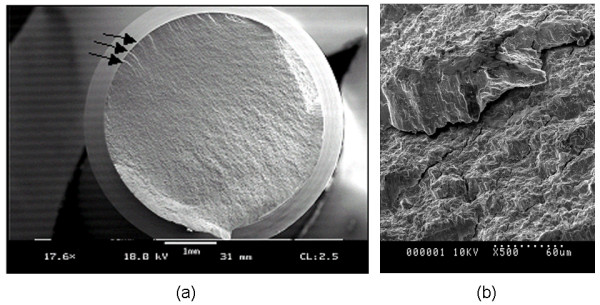
SEM micrograph showing a typical failure of titanium alloy locking screws. (a) The arrows indicate crack initiation locations. (b) A view of a rivulet within a crack initiation sight, showing numerous cracks throughout.